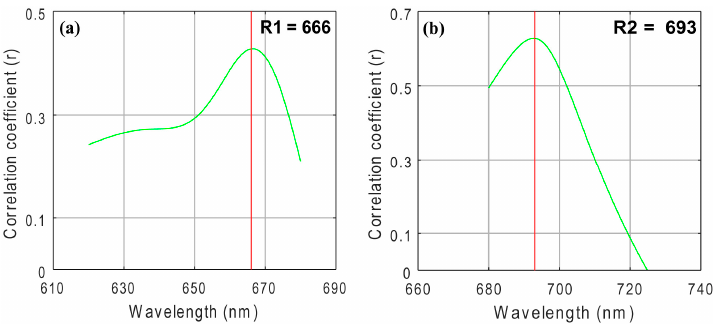
Figure 6. Selected wavebands for near-infrared/red algorithm using the tuning method ( a ) optimal band λ 1; ( b ) optimal band λ 2.